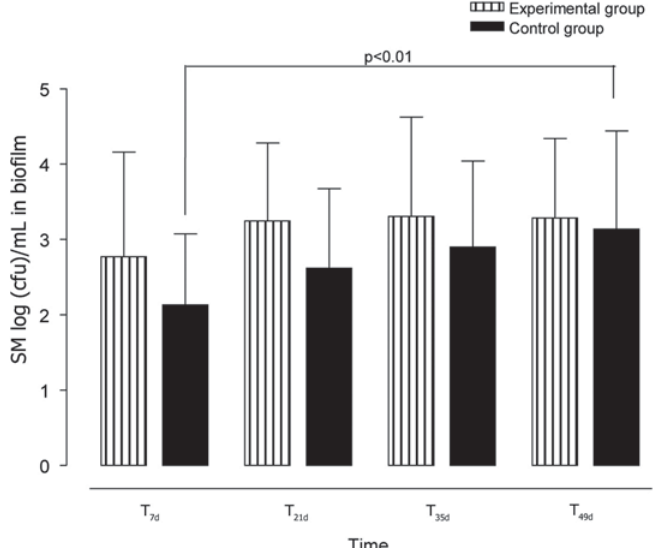
Figure 2- Means and standard deviations [log(cfu)/mL] of Streptococcus mutans (cid:3)(cid:76)(cid:81)(cid:3)(cid:69)(cid:76)(cid:82)(cid:191)(cid:79)(cid:80)(cid:3)(cid:73)(cid:82)(cid:85)(cid:3)(cid:72)(cid:91)(cid:83)(cid:72)(cid:85)(cid:76)(cid:80)(cid:72)(cid:81)(cid:87)(cid:68)(cid:79)(cid:3)(cid:11)(cid:41)(cid:88)(cid:77)(cid:76)(cid:3)(cid:50)(cid:53)(cid:55)(cid:43)(cid:50)(cid:3)(cid:47)(cid:38)(cid:12)(cid:3)(cid:68)(cid:81)(cid:71)(cid:3)(cid:70)(cid:82)(cid:81)(cid:87)(cid:85)(cid:82)(cid:79)(cid:3) (Transbond XT) groups at different times of collection